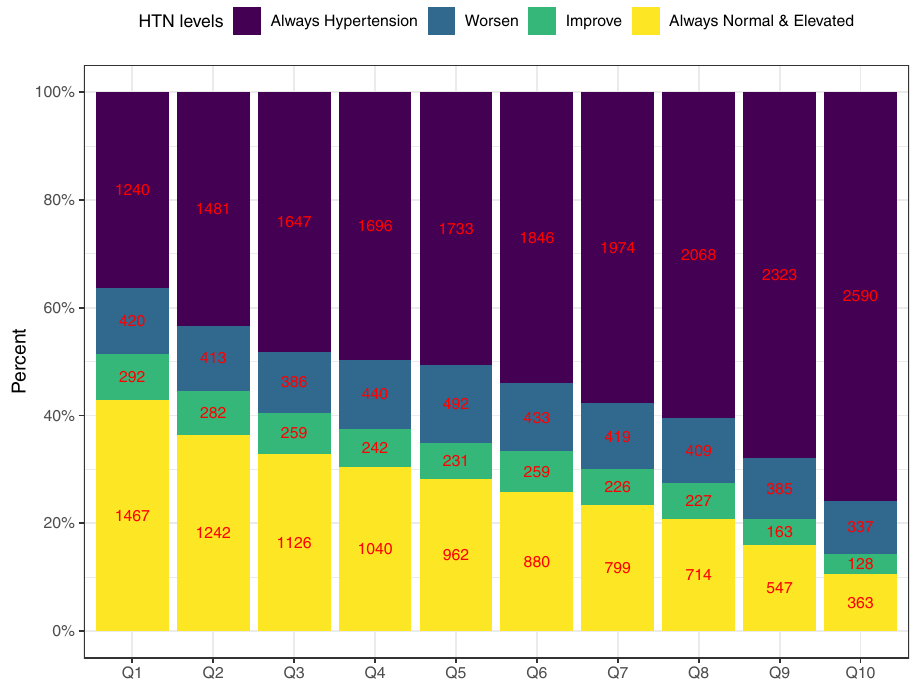
Fig. 4 Distribution of longitudinal categories of BP by deciles of the HTN-PRS. The fi gure visualizes the distribution of longitudinal BP categories in the stage 2 dataset: hypertension at both exams (treated and/or having hypertension in both exams), worsen (individuals having worse BP category in the follow-up exam compared to the fi rst) improved (individuals having better BP category in the second exam compared to the fi rst, only if they were not treated for hypertension at any point), and no hypertension in both exams (includes normal and elevated BP but without change in category), in deciles of the multi-ethnic HTN-PRS. The numbers provide the sample sizes represented by each